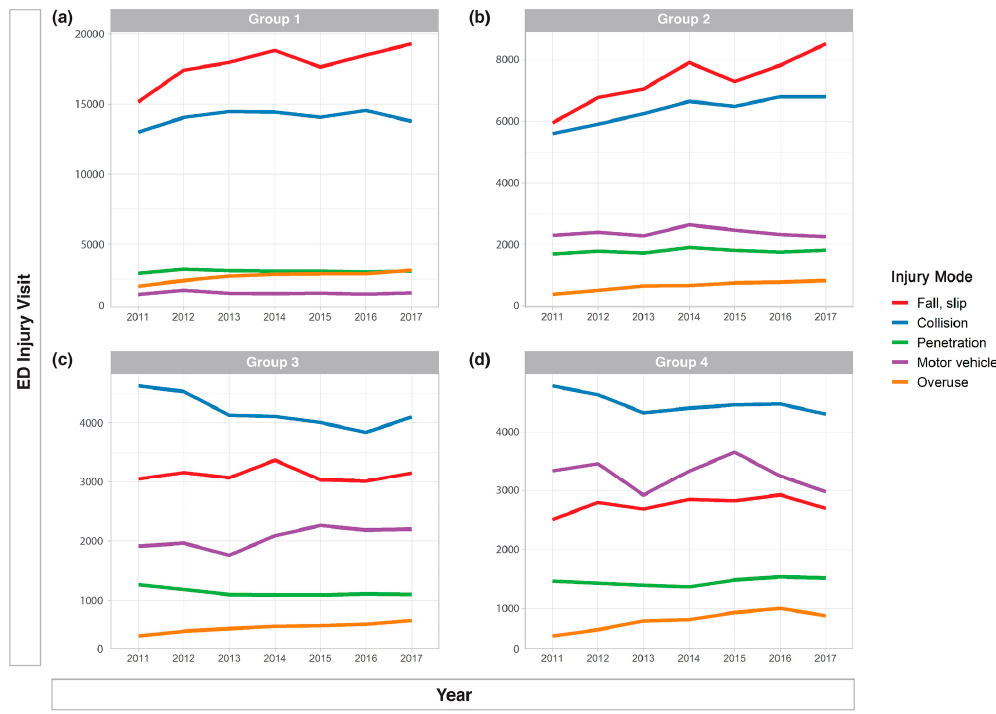
Figure 2. Five most common modes of injury by age group. ( a ) group 1 (0 to 4 years), ( b ) group 2 (5 to 9 years), ( c ) group 3 (10 to 14 years), ( d ) group 4 (15 to 19 years).